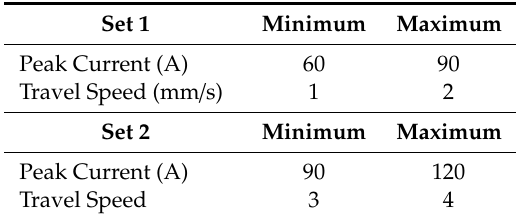
Table 3. Parameter ranges after division of the experiments into two